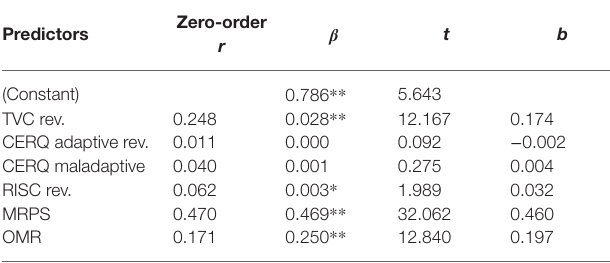
TABLE 2 | Multiple regression predicting perceived barriers to